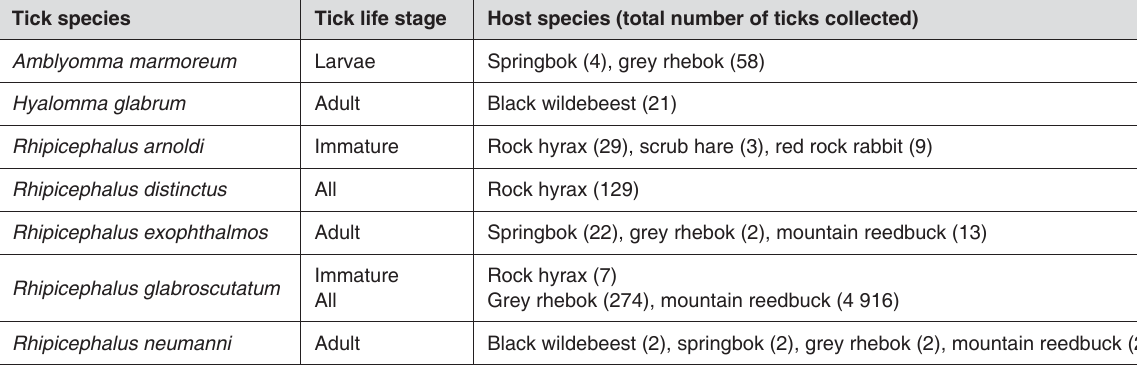
TABLE 4 Ixodid ticks collected from mammals in the Karoo National Park, South Africa Tick